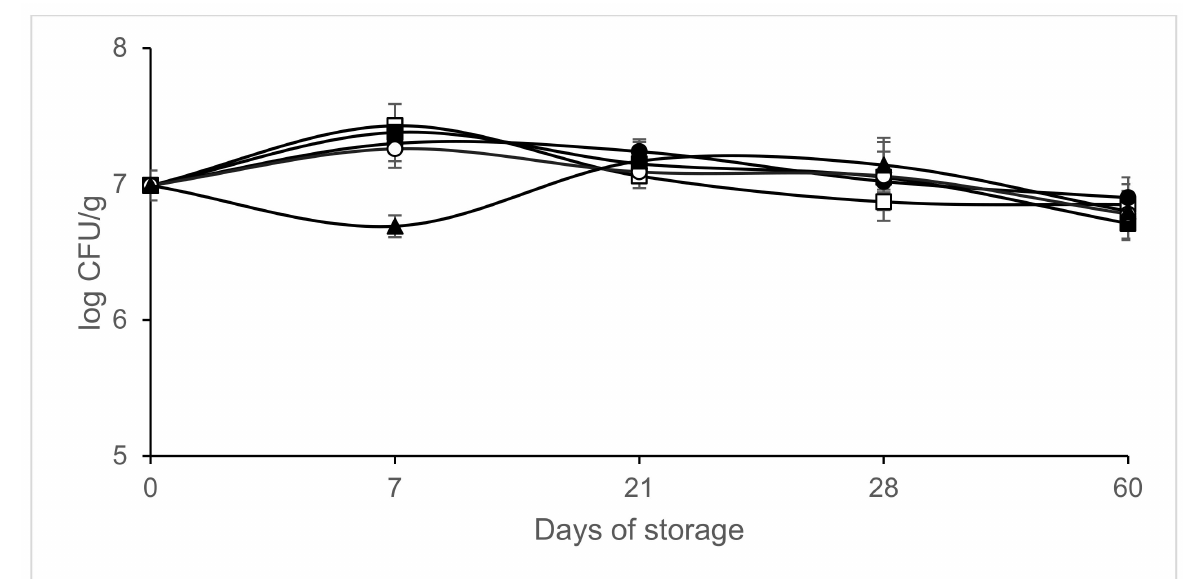
Figure 3. Effect of packaging conditions on lactic acid bacteria counts in inoculated sliced chorizo packaged in modified atmospheres. Packaging conditions: Air ( (cid:3) ), 100% Nitrogen ( (cid:4) ), Vacuum ( • ), 20% CO 2 /80% N 2 (